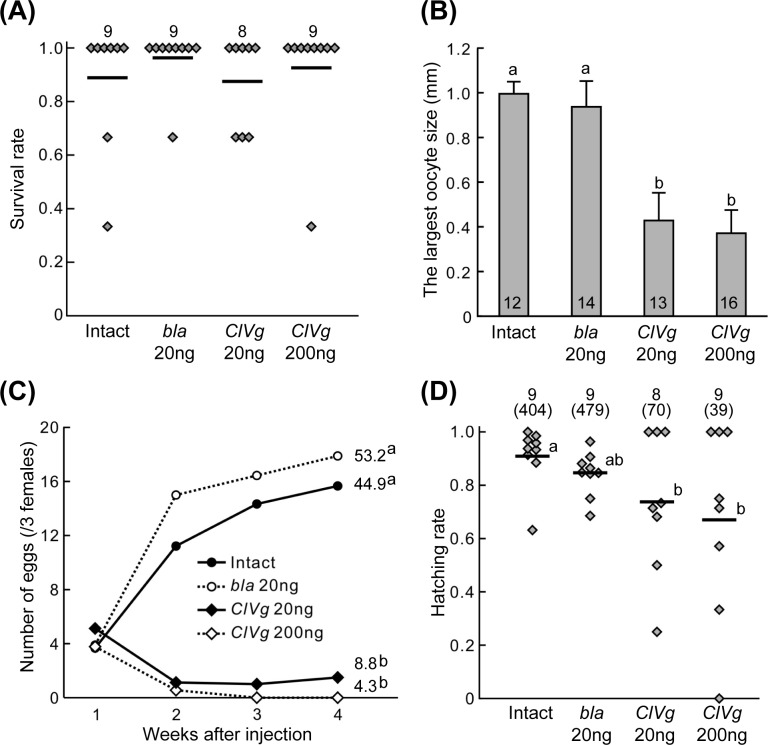
Effects of ClVg RNAi on reproductive performance of adult females of the bedbug.(A) Survival rates after dsRNA injection. Numbers of replicates each containing three adult females are shown at top. Rhombic points and bars indicate survival rates of individual replicates and their means, respectively. (B) Effects on oocyte size. The longitudinal length of the largest oocyte in the ovary was compared among the treatment groups. Means and standard deviations are shown. Numbers of adult females inspected are shown at the bottom of the columns. (C) Effects on oviposition. Mean egg numbers of 8–9 replicates each containing three females are shown. Mean accumulative egg numbers for the treatment groups are indicated on the right side. (D) Effects on egg hatching rate. Rhombic points and bars indicate replicates and their means, respectively. Numbers of replicates (and total egg numbers inspected for each treatment) are shown at top. In (A), there are no statistical differences among the treatment groups (a likelihood-ratio test of GLM, P > 0.05). In (B)-(D), different alphabetical letters (a, b) indicate statistically significant differences (a likelihood-ratio test of GLM followed by multiple comparisons, P < 0.05).